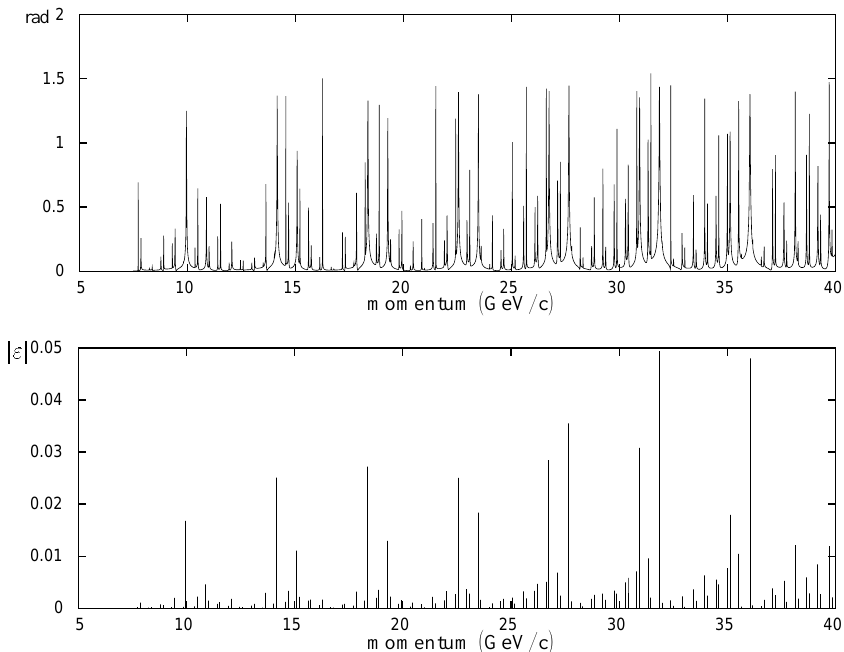
FIG. 2. SLIM opening angles of (cid:2) n (cid:2) (cid:2) z (cid:3) (top) and resonance strength (bottom) for a beam with normalized vertical emittance of 4 p mmmrad in PETRA.